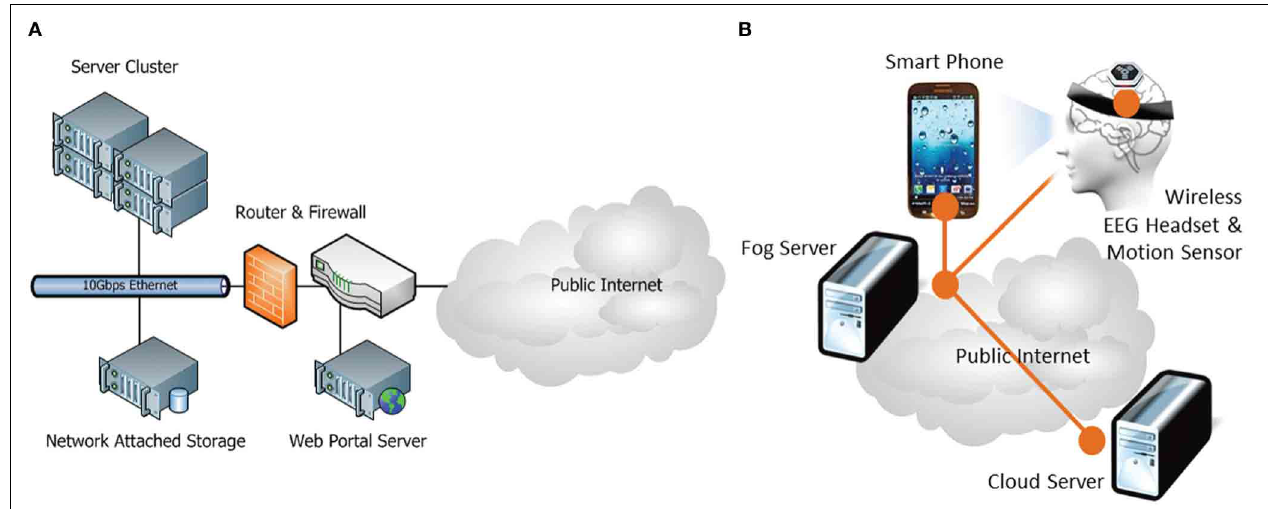
FIGURE 4 | Pilot system architecture of (A) Cloud Computing site at NCHC, Taiwan and (B) Fog Computing sites at NCTU PET Lab, Taiwan and UCSD SCCN, San Diego, California.